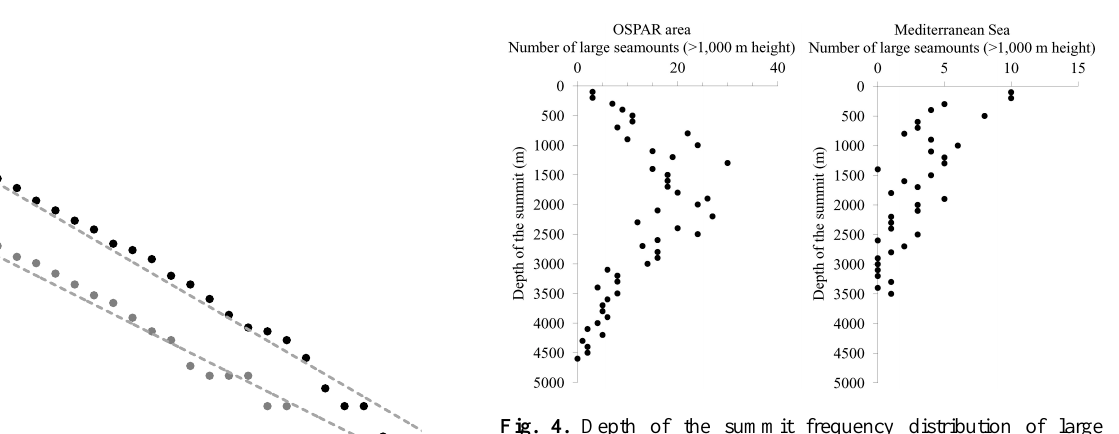
Fig. 4. Depth of the summit frequency distribution of large (height > 1000m) seamount-like features in the OSPAR area (left) and in the Mediterranean Sea